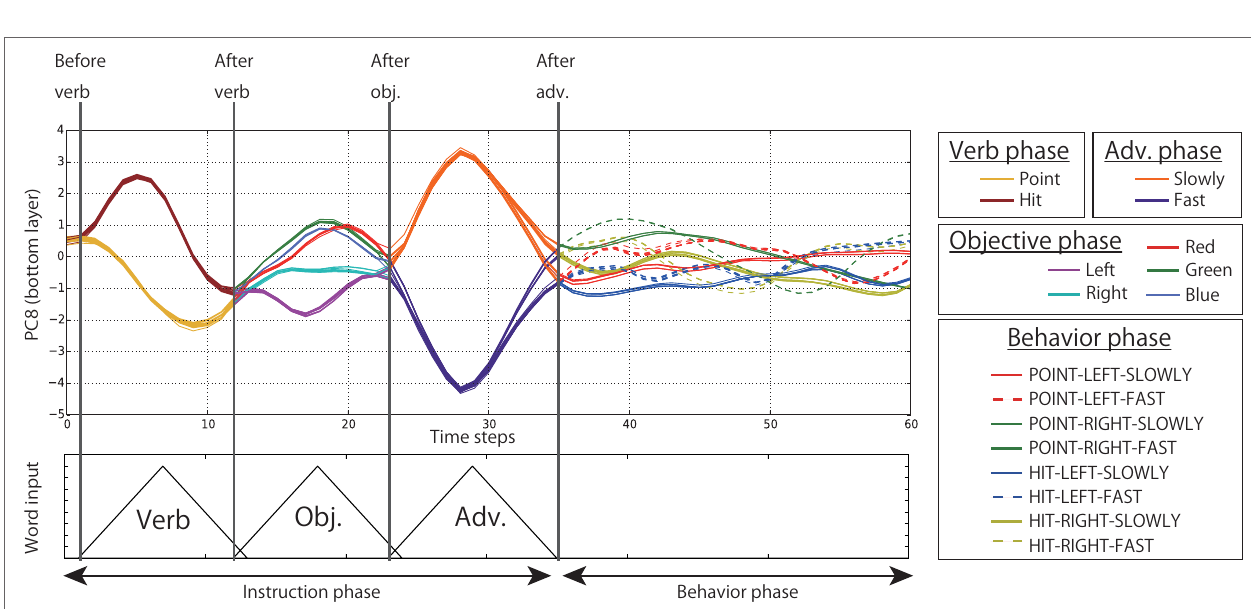
POINT-LEFT-SLOWLY POINT-LEFT-FAST POINT-RIGHT-FASTPOINT-RIGHT-SLOWLY HIT-LEFT-SLOWLY HIT-LEFT-FAST HIT-RIGHT-SLOWLY